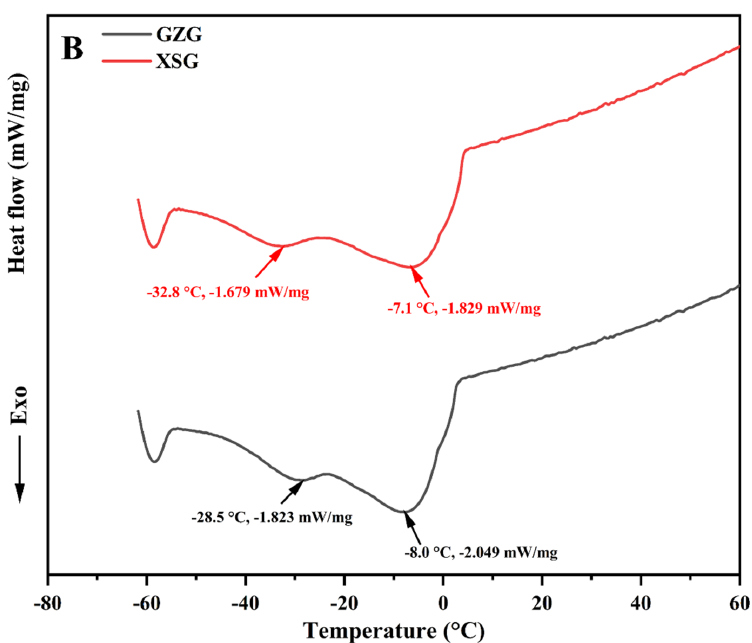
Figure 4. Melting ( A ) and crystallization ( B ) profiles of goat milk fat samples analyzed by differen- tial scanning calorimetry. Guanzhong goat milk (GZG, black curve), Xinong Saanen goat milk (XSG, red